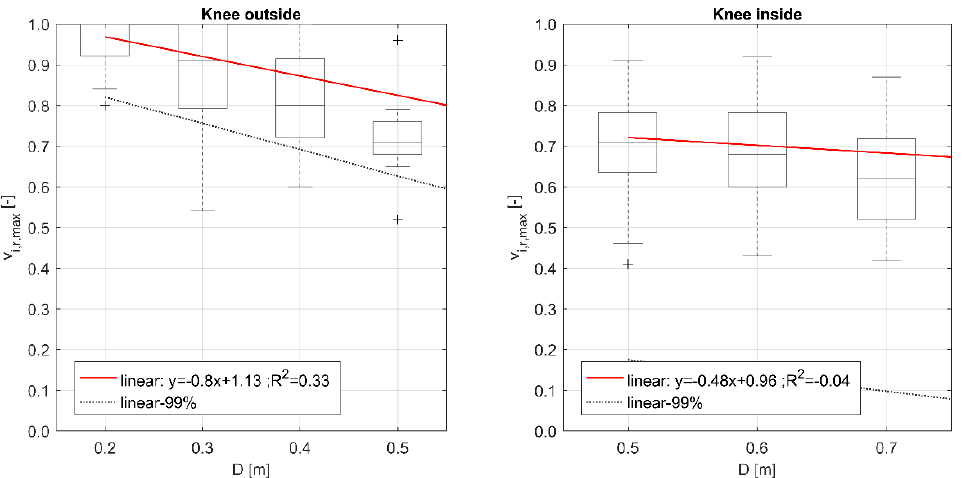
Figure 16. Effects of knee position (outside and inside the floodwater level) on the normalized speed variation depending on D , by normalizing the speed values by v r,max . The regressions are shown for running conditions. Linear regressions (dashed lines refer to prevised values outside of the tested D range) and boundary conditions (99%) are shown.